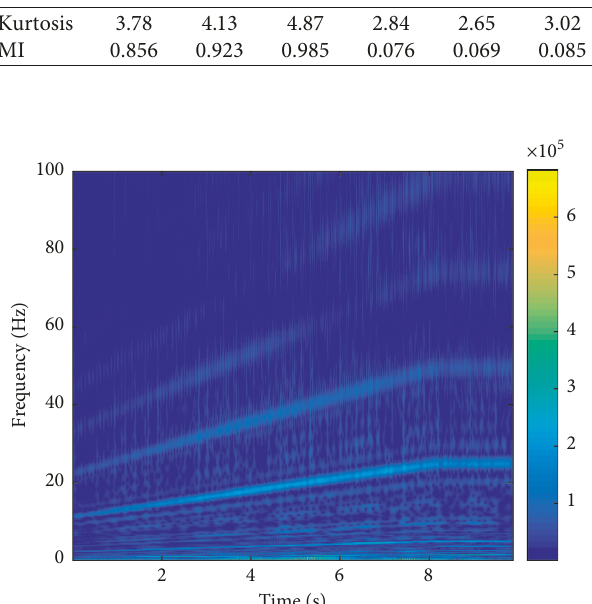
Figure 21: Time-frequency representation of rolling bearing vi- bration signal with rising speed based on VMD-SET.